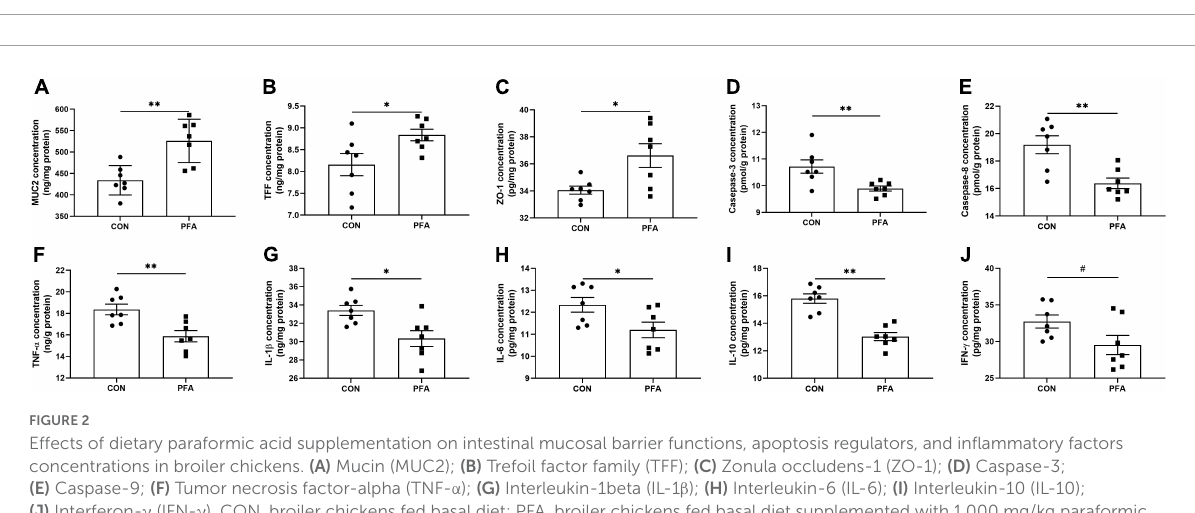
ratio were analyzed according to the method described in Chen et al.